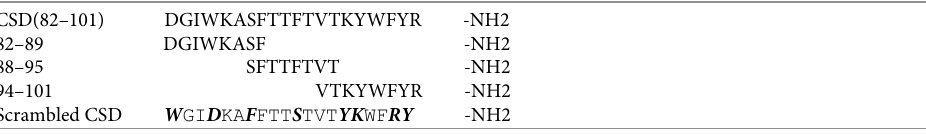
Table 1. Sequences of CSD, subregions, and scrambled